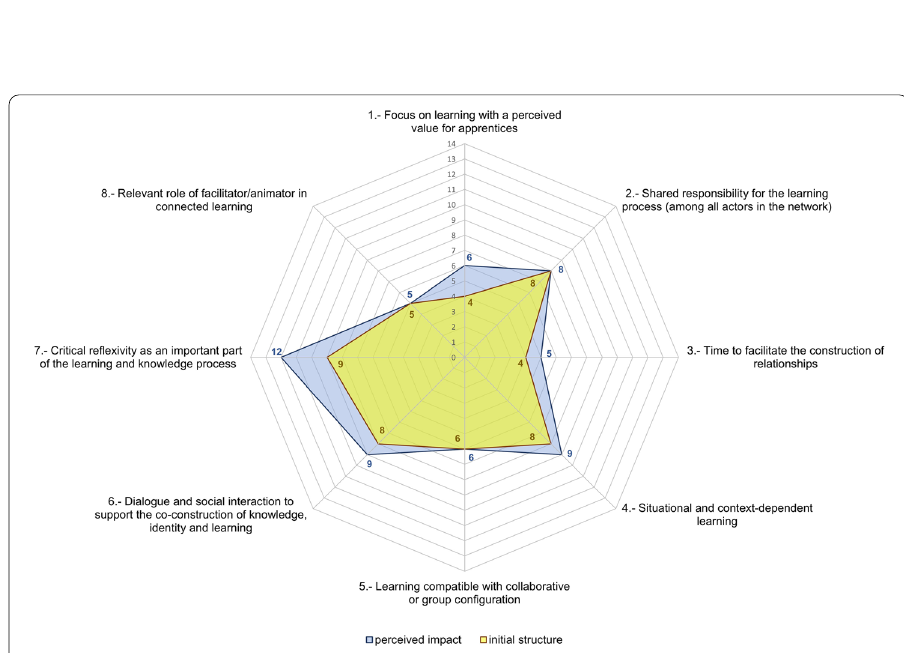
Fig. 4 NLP differences between perception results and initial structure on D1. The scale represents the maximum value observed between initial and perceived structures. Source: Authors’